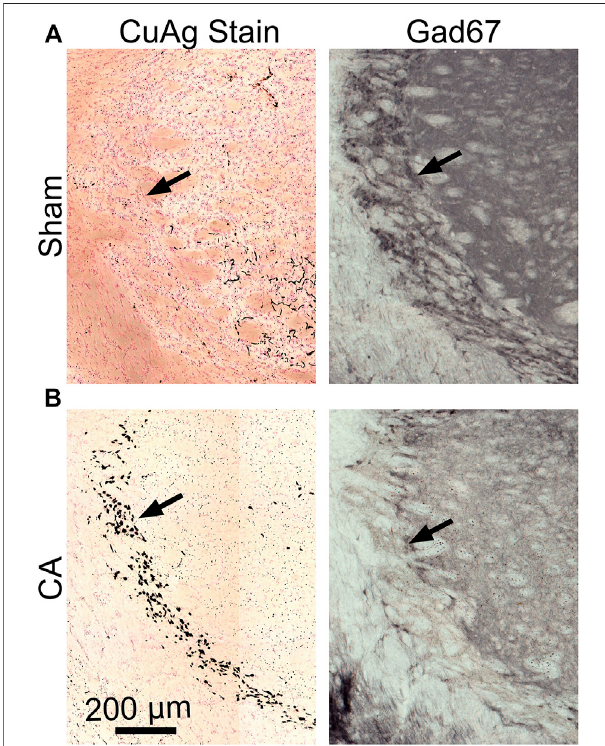
FIGURE 5 | Gad67-stained and CuAg-stained sections from the same brain regions of the same representative sham or insult rats (A) The intermediate RT from sham section with lacking silver staining (left) shows prominentGad67 + neuronswhileRTfromCAsection (B) withprominent CuAg + stain in soma show a remarkable reduction of Gad67 + neurons. Scale bars represent 200 µM.